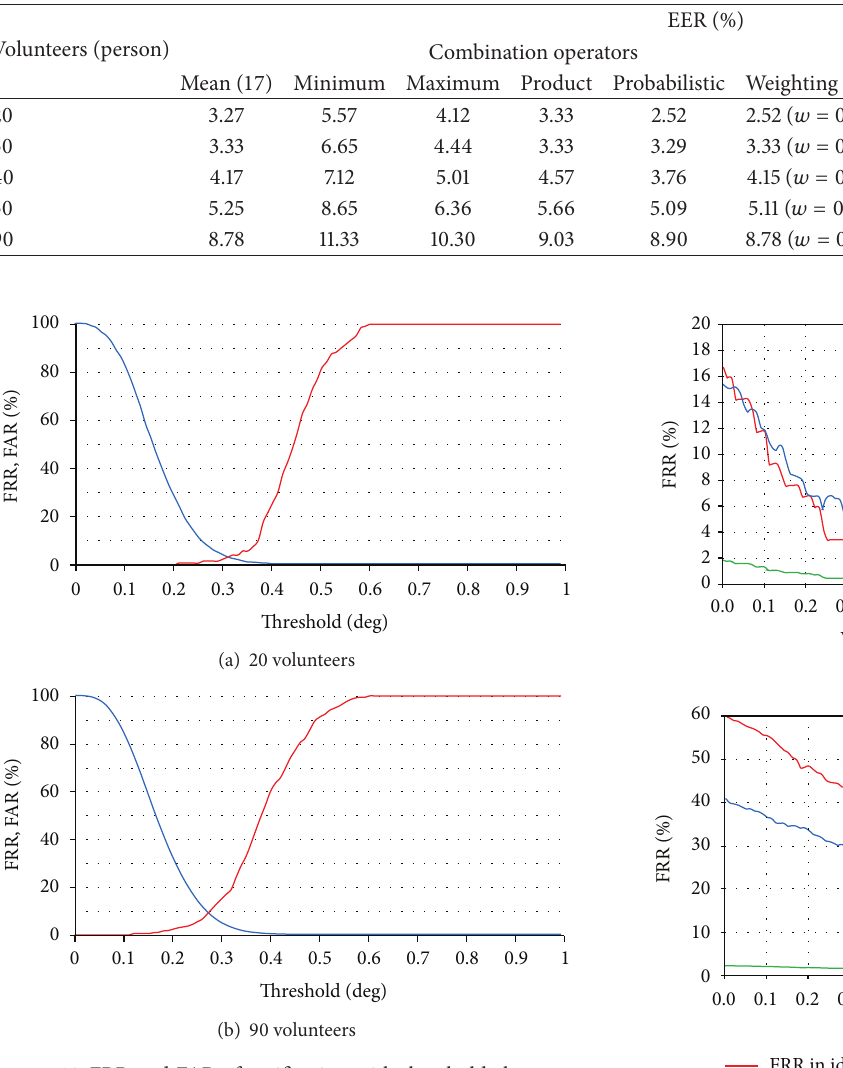
Figure 14: FRR and FAR of verification with threshold change on mean operator.